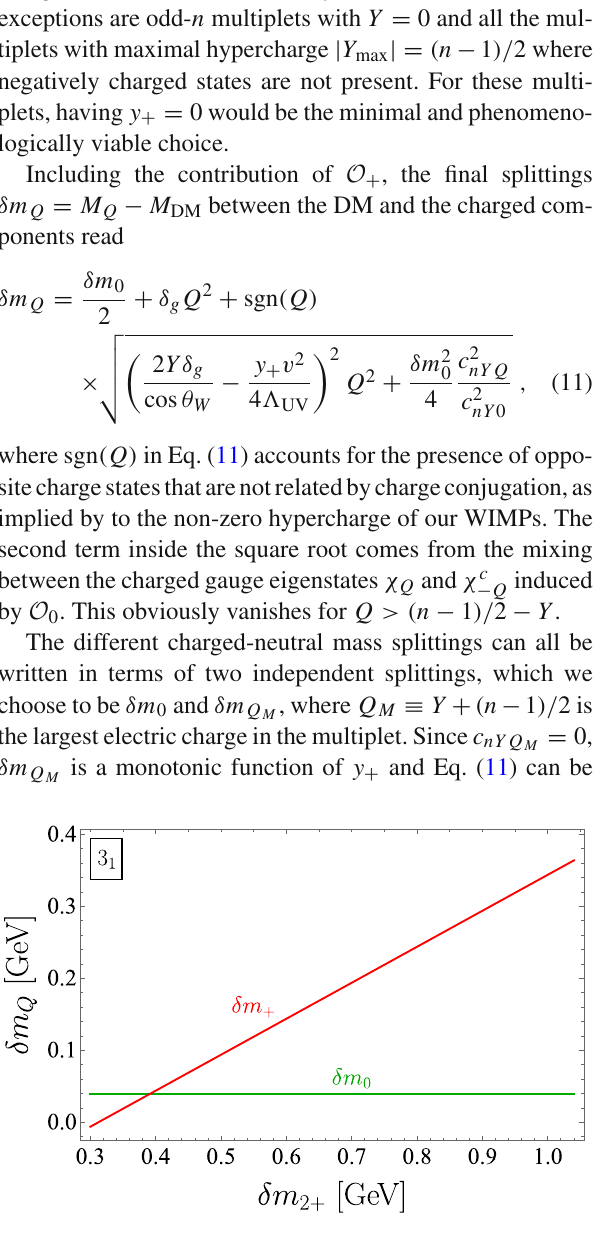
Fig. 2 Mass splittings of 3 1 (left) and 4 1 / 2 (right) as a function of δ